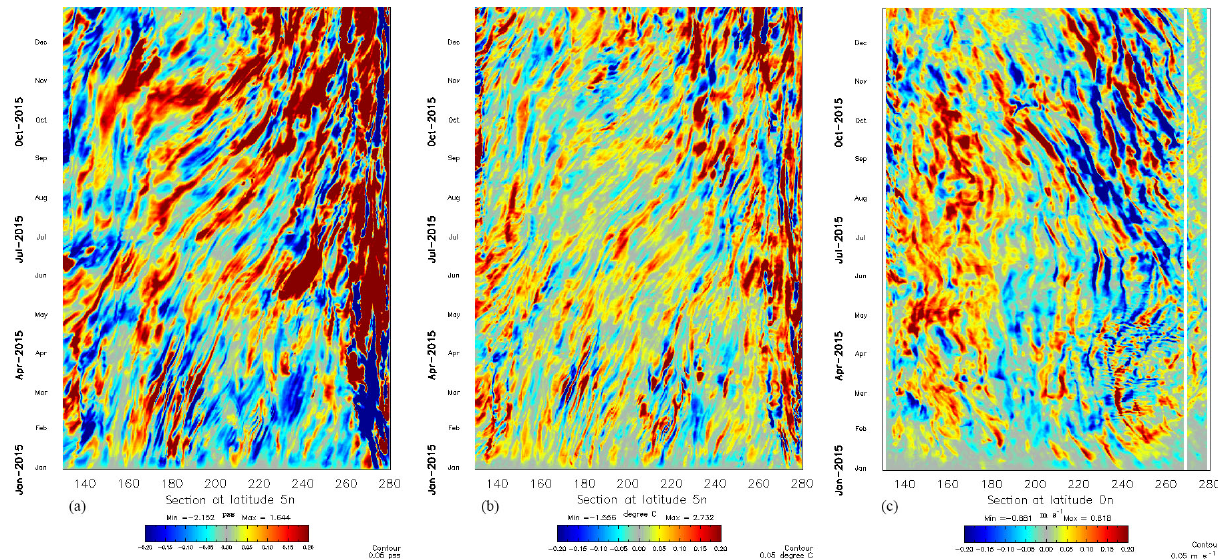
Figure 12. Hovmöller diagram of differences in SSS (a) , SST (b) at 5 ◦ N and sea surface zonal velocity ( U ) (c) at the Equator between the SMOSexp and the REF experiment in